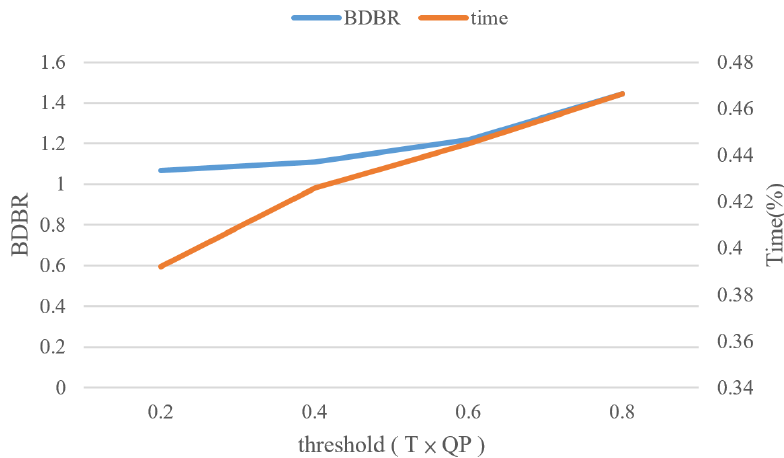
Figure 6. Relationship between BDBR, time reduction, and threshold ×